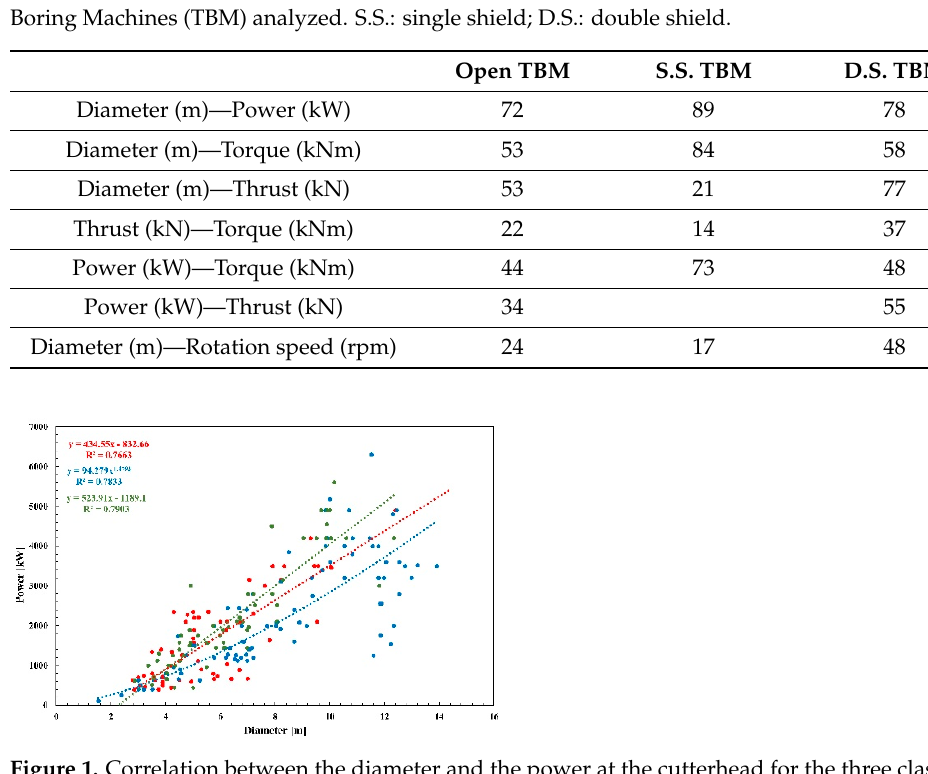
Figure 1. Correlation between the diameter and the power at the cutterhead for the three classes of TBM analyzed. Red: open TBM; blue: single shield TBM; green: double shield TBM. The trend of the torque vs. the diameter is given in Figure 2. The correlations are represented by a linear function in the case of open TBMs and by power functions for single and double shield TBMs. The results are in line with those obtained by [42]. It can also be noticed that in the whole domain, with the same diameter, single shield machines operate with a larger torque. In the range of diameters between 3 and 7 m, the perfor ‐ mance of open TBMs and that of double shield TBMs are very similar. Over 7 m, the gap increases progressively as the diameter increases, and, for the same diameter, the open TBMs work with a lower torque compared to the other two types of machines. A higher concentration of data in the range of diameters between 2 and 9 m is also noticeable. Fur ‐ thermore, in the same range, the range of the torque is small, and the model approximates the experimental points very well. Figure 2. Correlation between diameter and torque. Red: open TBM; blue: single shield TBM; green: double shield TBM. A kind of correlation, expressed by a logarithmic trend, is observed in open TBM between the diameter and the thrust (Figure 3), characterized by R 2 = 0.6417. In general, these two parameters are not very well correlated, as the thrust depends only in part on the diameter, whereas it is mainly conditioned by the geomechanical characteristics of the rock mass. On the other hand, the correlation (R 2 < 0,5) in the single shield TBM is poor. Considering the intersection of the domains of the three functions and examining, there ‐ fore, a range of diameters between 2 and 12.5 m, the trend represented by single shield TBMs is always above the other two functions. As for the double shield TBMs, also in this case the correlation is low. However, a model consisting of a power function was consid ‐ ered, with R 2 = 0.4089. The processed data ( n = 77), are correctly distributed along the function up to a diameter of 5 m; in the range 2 to 6 m, the trends of the open and double shield TBMs are very similar. Over 6 m, with the same diameter, the thrust exerted by the double shield TBM is greater than that exerted by the open TBM; however, starting from these values, the dispersion of the experimental points increases considerably. [43] stated